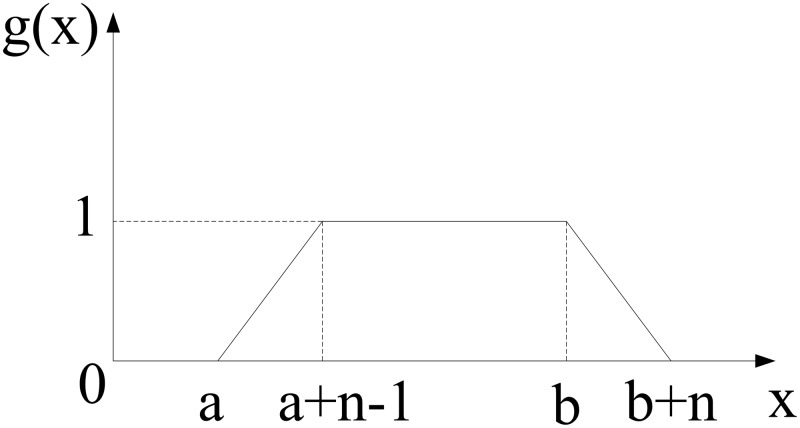
Illustration of the function x solution of Eq 5.